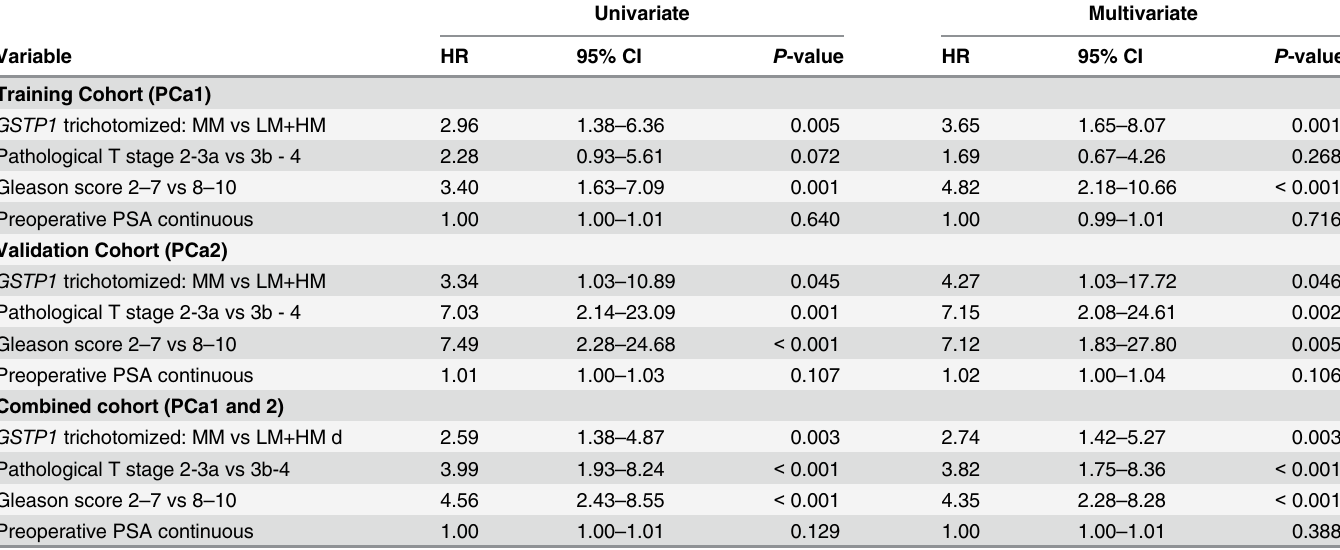
Table 4. Univariate and multivariate Cox regression analysis of clinical failure in high-risk prostate